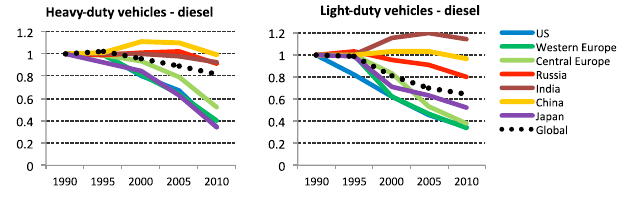
Figure 2. Change in implied BC emission factors for road diesel vehicles in selected countries and world regions; changes relative to 1990 in ECLIPSE V5a